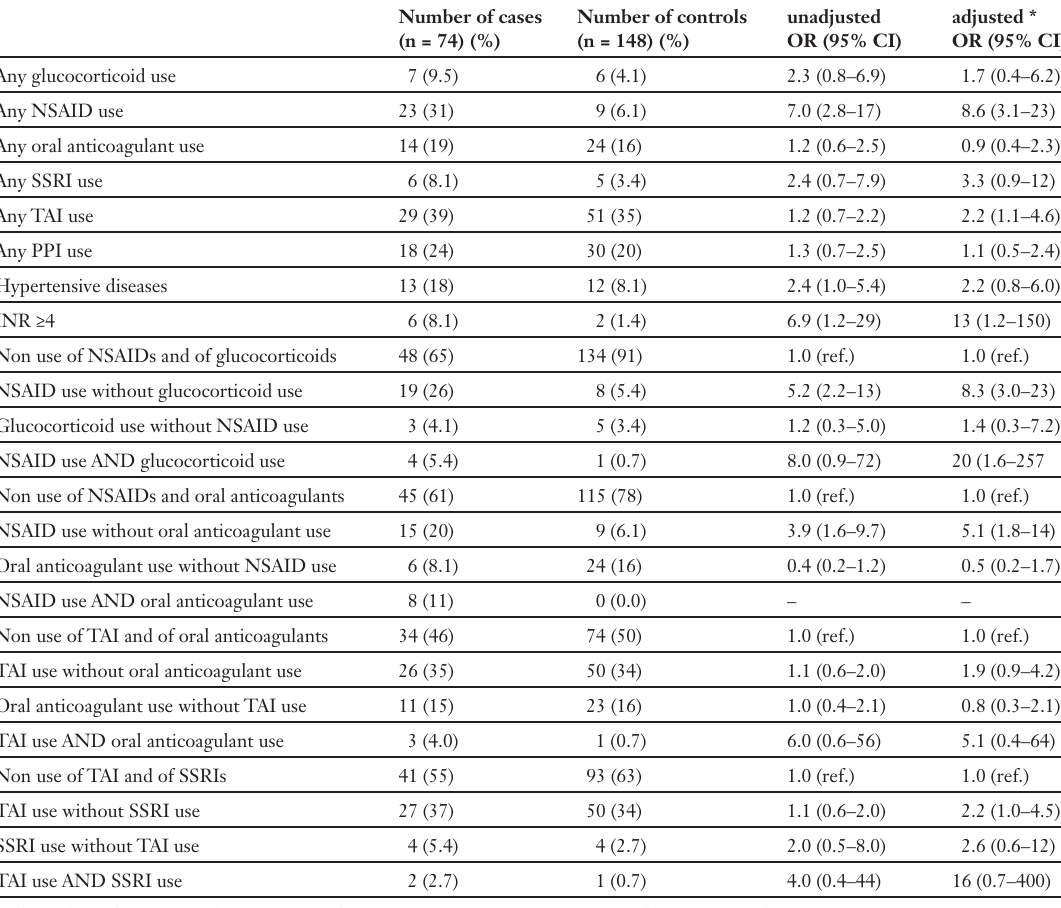
Table 2 Risk estimates for first-time GI-bleeding associated with indi- vidual use of drugs and concomitant use of drugs (drug-drug